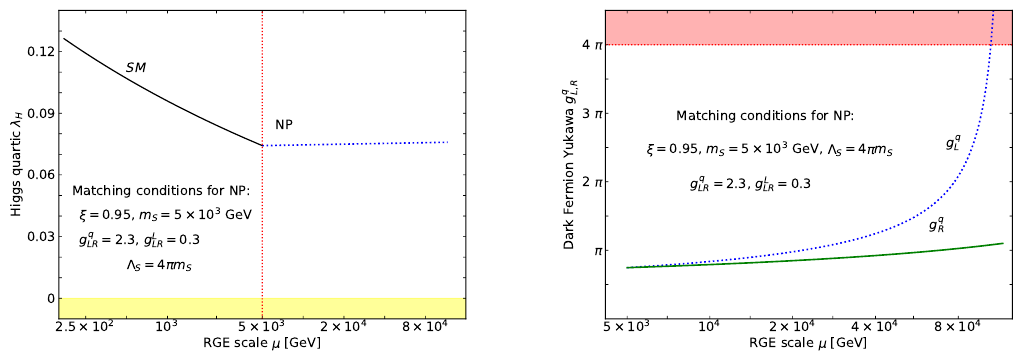
Figure 3 . Left panel: evolution of the Higgs boson quartic coupling with the RG scale. The trilinear coupling Λ , entering the expressions obtained for the SM Yukawa operators, is set at S the maximum value allowed by unitarity. The red dashed line indicates the matching scale, which separates the SM evolution of the parameter from its continuation determined by new physics. Right panel: evolution of the dark Yukawa coupling with the RG scale. Because of the large initial value selected by the considered value of Λ , the evolution of parameters is stopped by the emergence of S a first Landau pole at µ ’ 10 5 GeV, which defines the UV cutoff for the